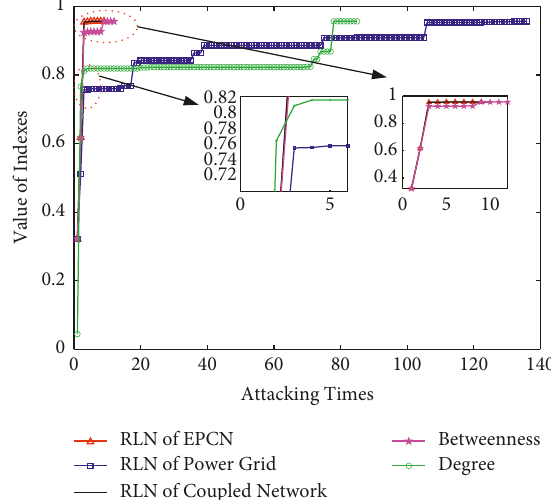
Figure 11: Indexes curve of 5 modes under cyber attacks.